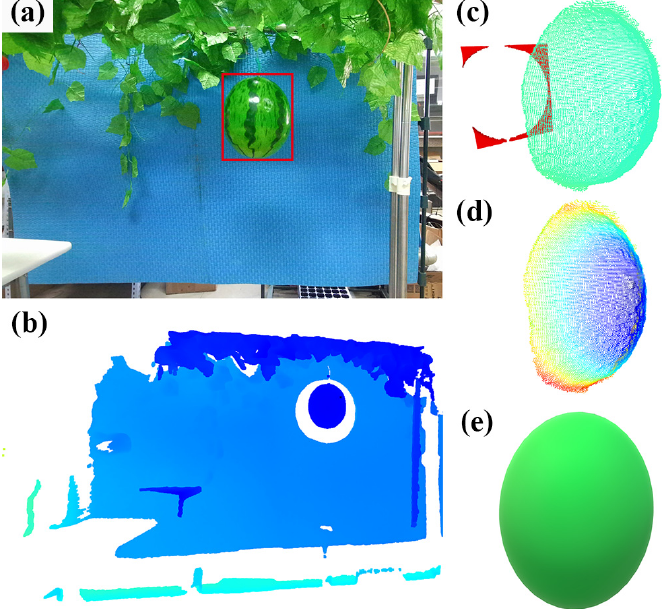
Figure 8. Grasping point positioning method: ( a ) the colour image; ( b ) the point-cloud information; ( c ) the point cloud in the rectangular box; ( d ) the watermelon point cloud obtained after performing clustering; ( e ) the fitted ellipsoid.